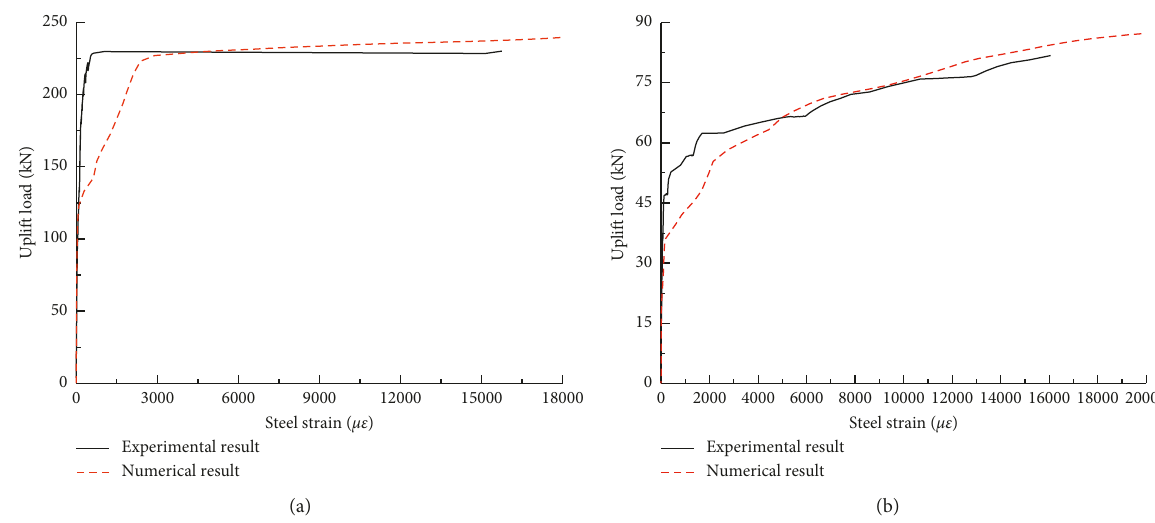
Figure 11: Comparison of the load-strain curve between numerical result and experimental result for the typical model. (a) NJ1. (b) NJ8.